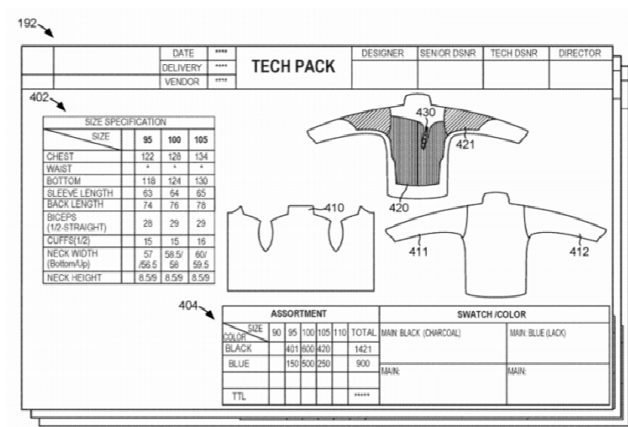
Figure 4. Tech packs for manufacturing.